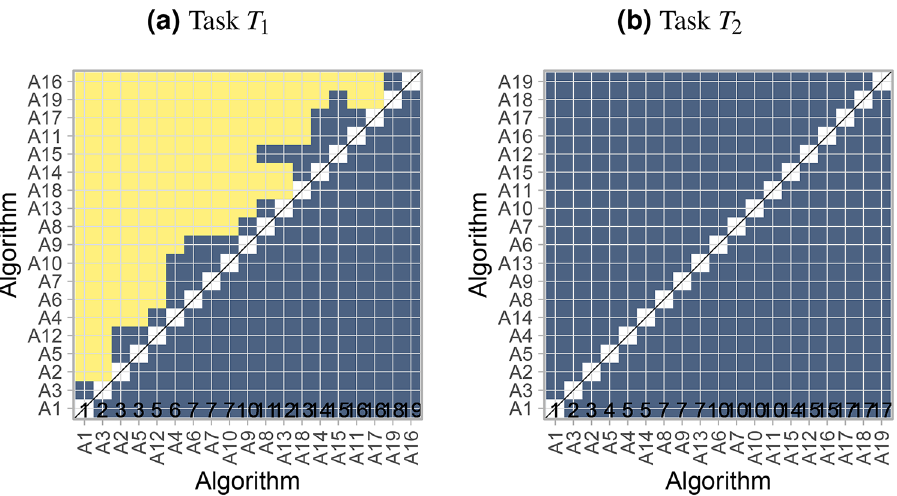
Figure 14. Significance maps for selected tasks of the MSD for visualizing the results of significance testing.